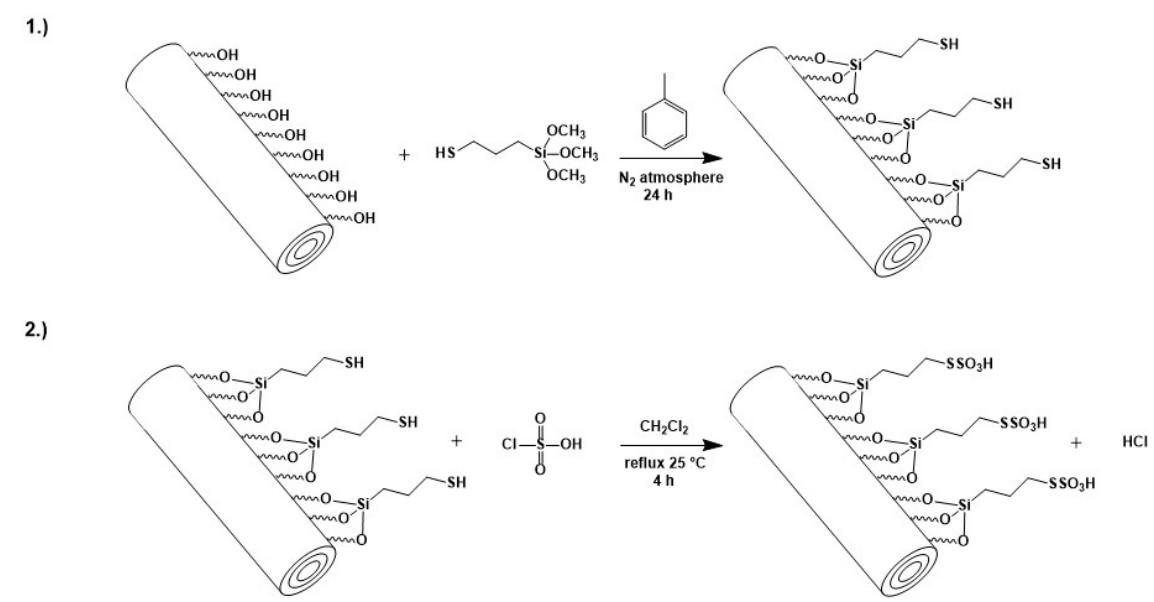
Figure 2. Two-step synthesis of HNT-MPTMS-SO 3 H consisting of organosilylation ( 1. ) and sulfona- tion step ( 2. ) according to Silva et al. and Peixoto et al. [16,17].